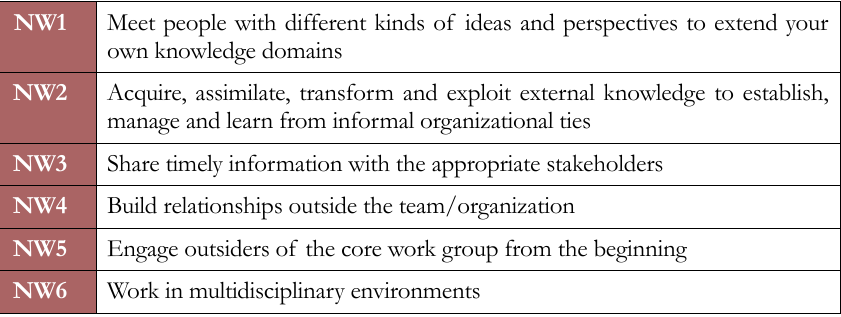
Table 7. Behavioral indicators in the FINCODA Networking